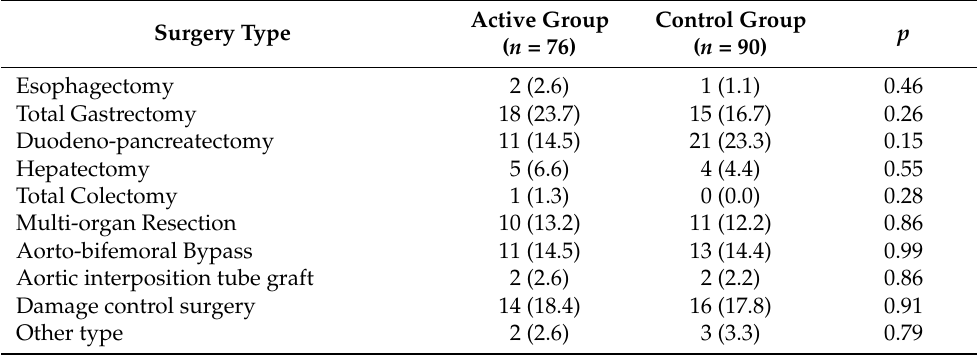
Table 3. Surgical procedures performed on the studied